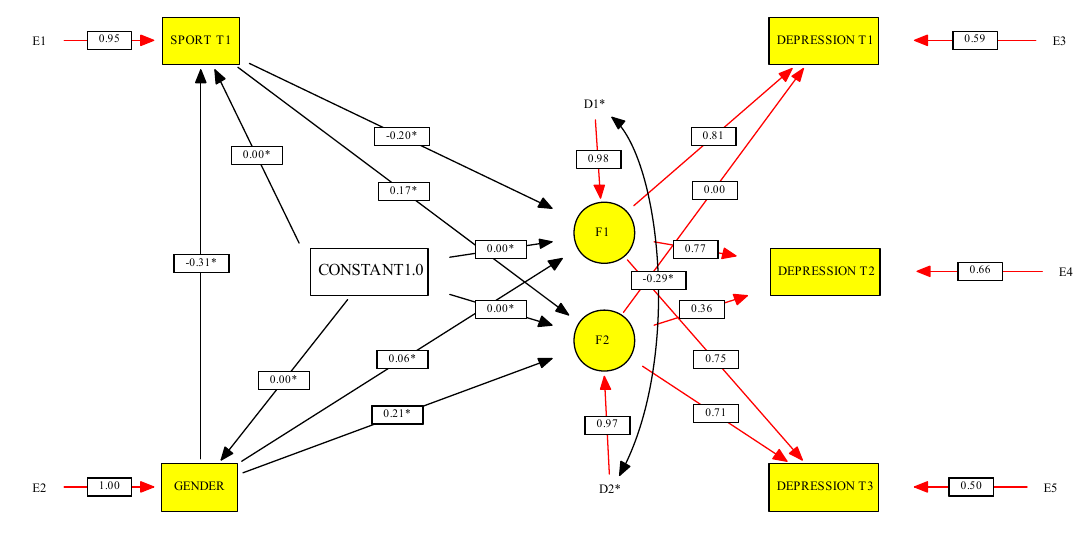
Figure 2. Latent growth curve model. * Significant at p < 0.05.